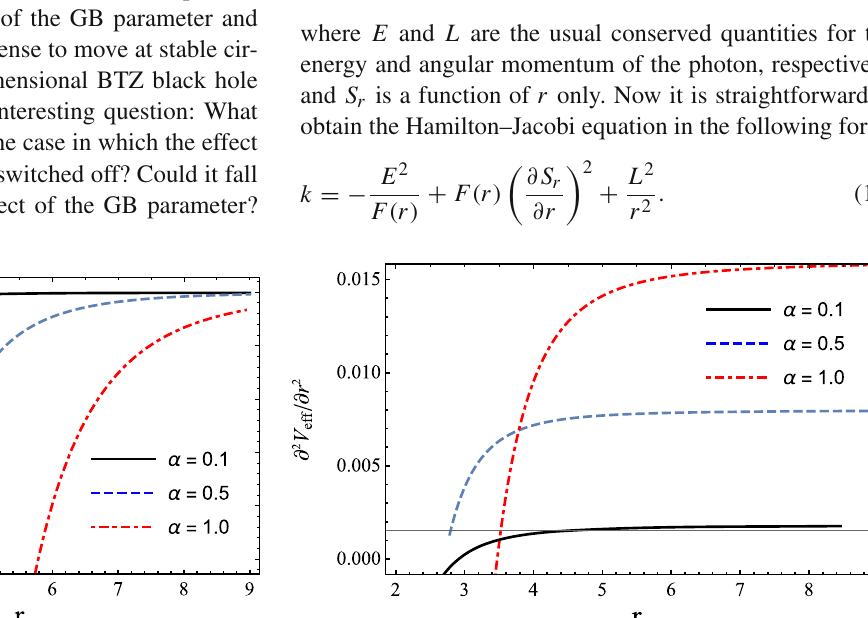
dimensional BTZ black hole in Einstein gravity, the situation is totally altered from the one in GB gravity where V (cid:6)(cid:6) does not depend upon eff = − 8 (cid:4) ), and hence there occur no stable circular orbits for r , ( V (cid:6)(cid:6) eff massive particles (see for example